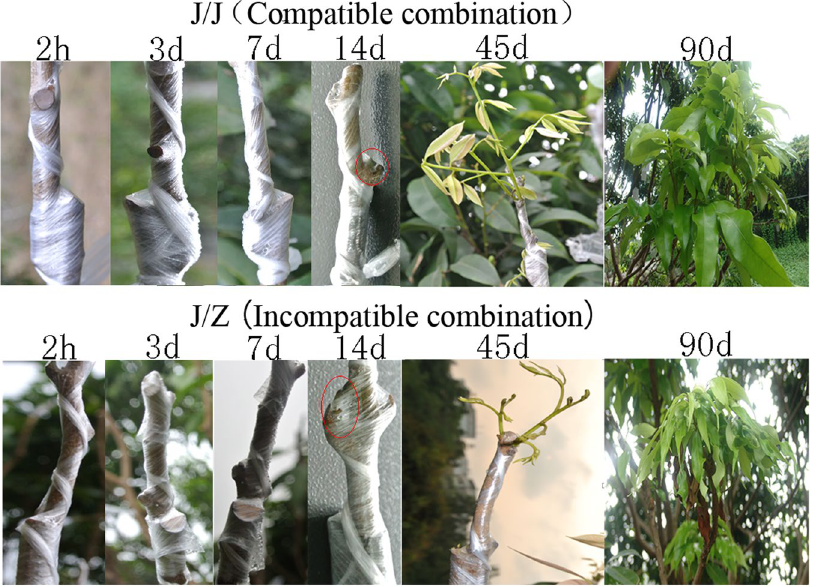
Figure 1. Field performance of the litchi compatible graft J/J and incompatible graft J/Z at 2 h, 3 d, 7 d, 14 d, 45 d and 90 d after